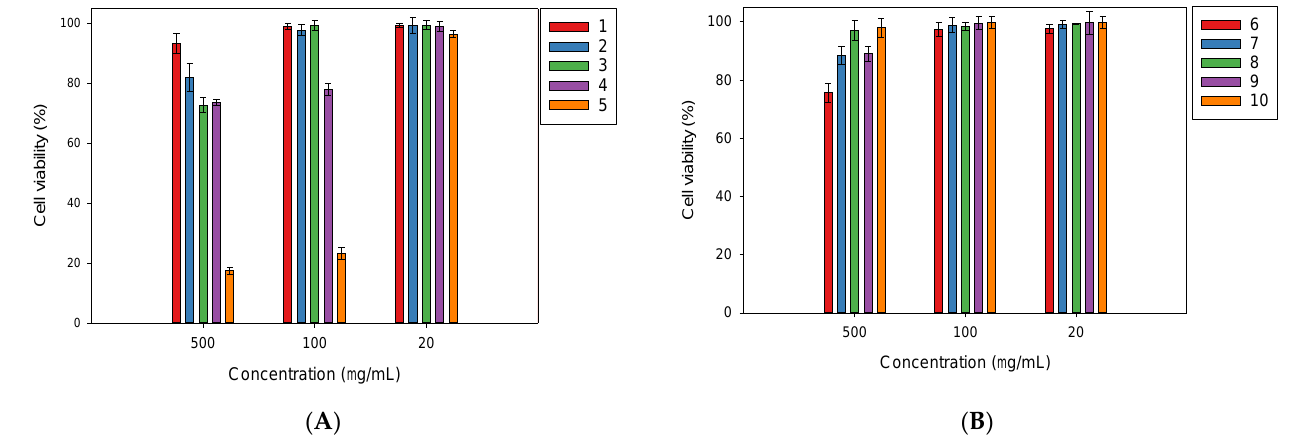
Figure 3. Viability of RAW264.7 cell line treated with the isolated compounds from Millettia speciosa . ( A ): (Compounds —